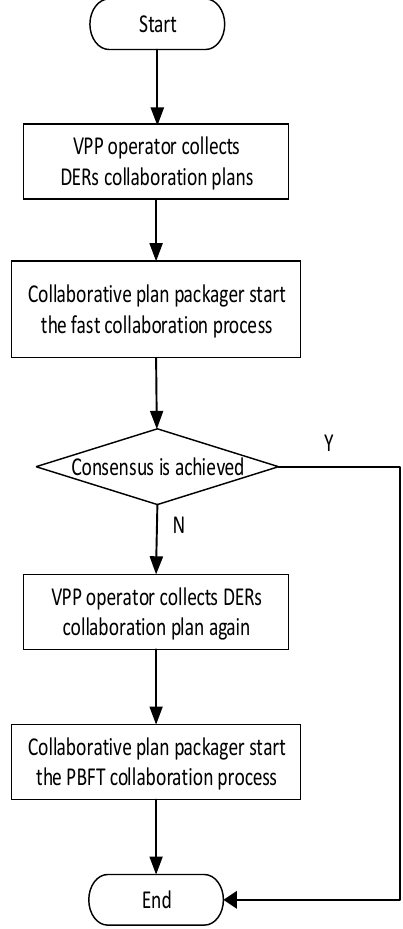
Figure 6. Operation logic of BNCM.